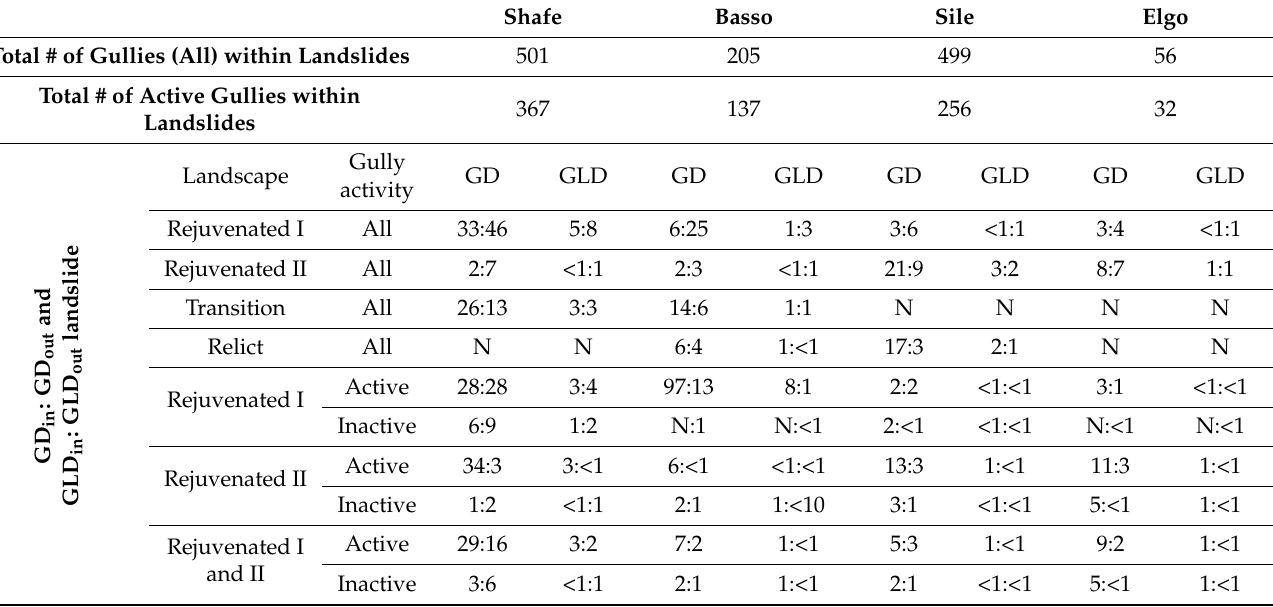
Table 3. Landslide and gully interaction for each landscape of the river catchments. Shafe Basso Sile Elgo Total # of Gullies (All) within Landslides 501 205 499 56 367 137